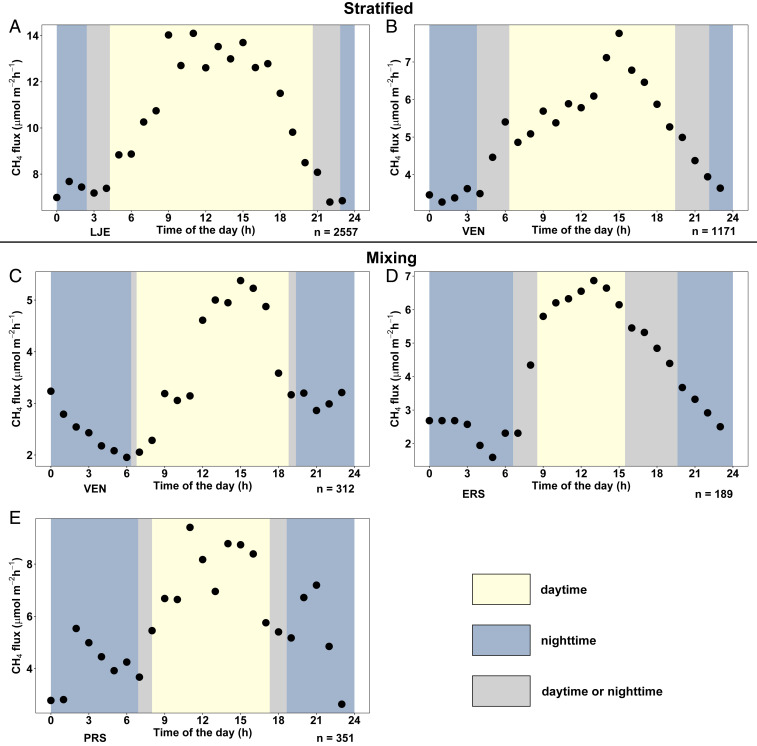
Mean (geometric weighted average; for details see Materials and Methods) of hourly CH4 fluxes over the full diel cycle (black dots) in the lakes LJE (A) and VEN (B) during stratified period, and in VEN (C), ERS (D), and PRS (E) during the mixing period (n = 4,580). Colored areas indicate day (yellow) or night (blue) during the time of the measurements, depending on the time of the year at a given location. Gray indicates times that during the sampling period was classified either as day or night.